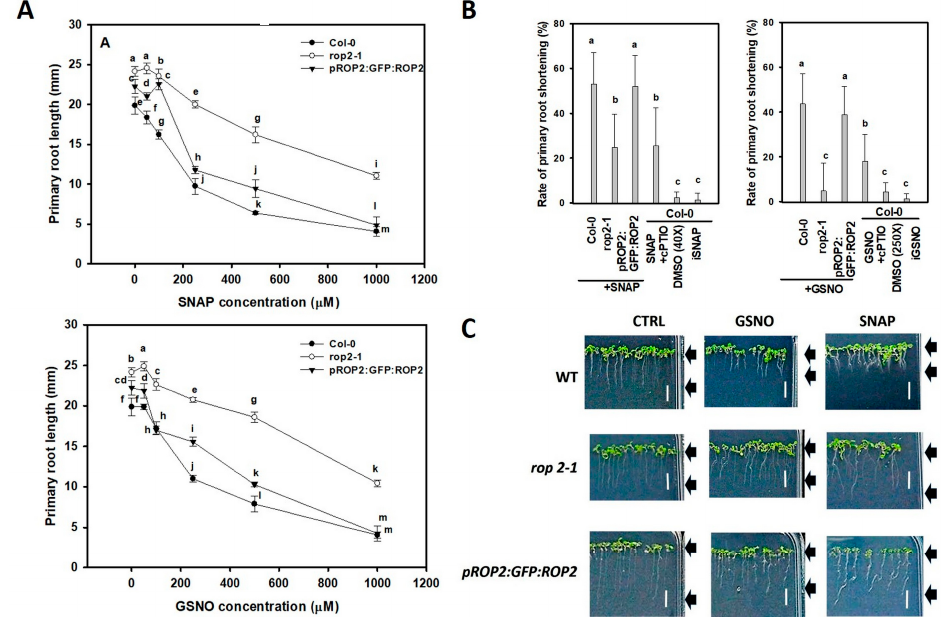
Figure 1. ( A ) Primary root length (mm) of Col-0, rop2-1 ; and pROP2:GFP:ROP2 complemented rop2-1 (labelled as pROP2:GFP:ROP2) Arabidopsis lines treated with 0, 50, 100, 250, 500, or 1000 µM SNAP or GSNO for 72 h. ( B ) Percentage values of primary-root shortening induced by 250 µM SNAP or GSNO in the investigated lines of Arabidopsis. Appropriately diluted DMSO, light-inactivated NO donors (iSNAP and iGSNO), and 250 µM SNAP/GSNO plus 800 µM cPTIO served as control treatments. ( C ) Images of seedlings of the same Arabidopsis lines treated with 250 µM SNAP or GSNO for 72 h. Arrows indicate the approximate length of the roots. CTRL is the control treated only with the solvent (DMSO in 250-fold and 40-fold dilutions for GSNO and SNAP, respectively). Bar = 10 mm. Data in ( A , B ) are averages and standard errors from three independent experiments with at least 10 roots each. Multiple comparison analyses were performed with SigmaStat 12 software using analysis of variance and Duncan’s test. Different letters sign significant difference at the p < 0.05